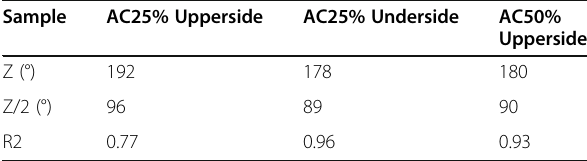
Table 2 Fiber orientation (Z/2) along the preferred axis of the AC25% and AC50% hygromorphs. A comparison of the upperside and underside of fabricated AC25% specimens showed slight differences for Z/2